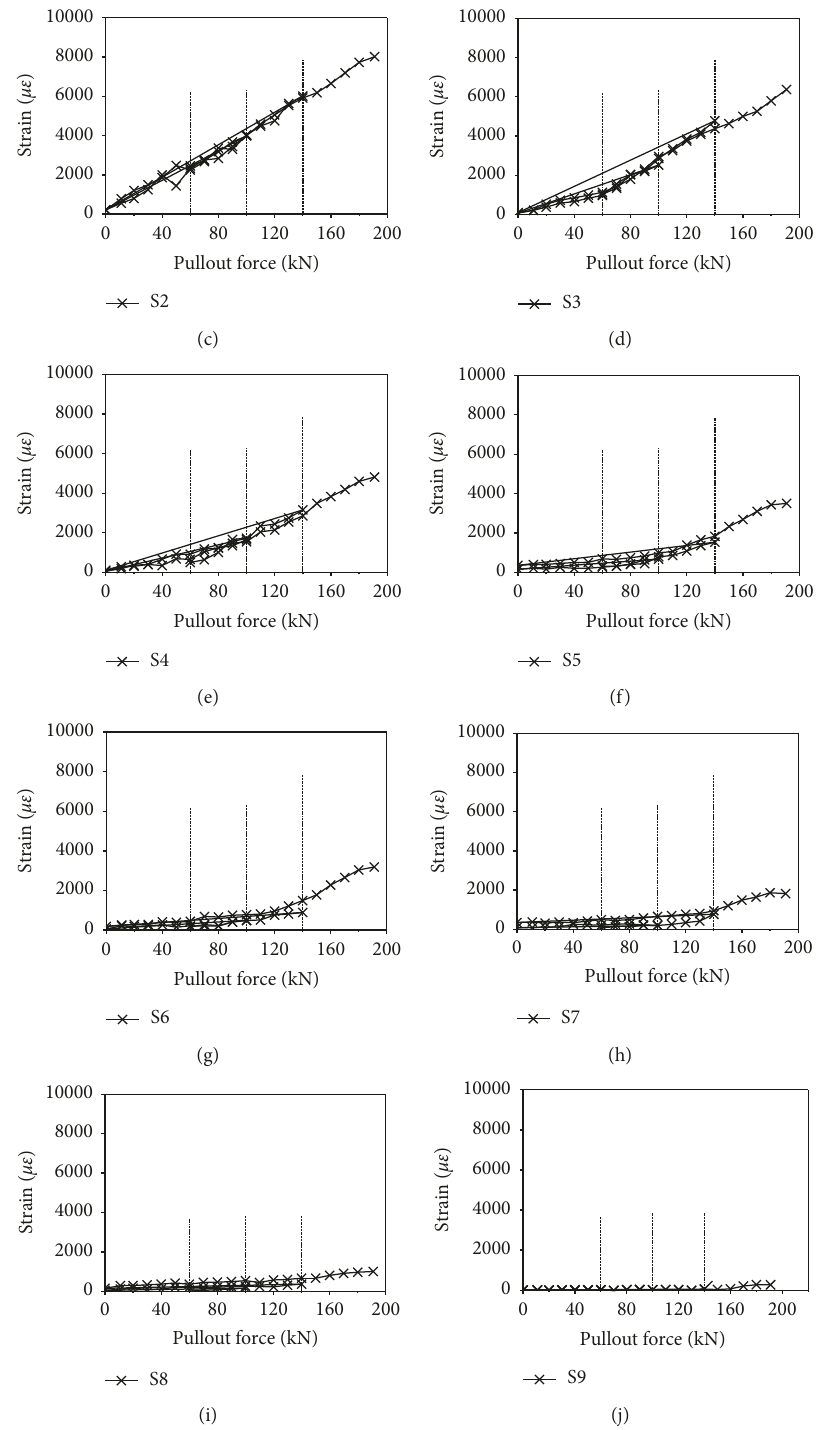
Figure 10: Cycle-load strain curves of GFRP bars under strong constraint